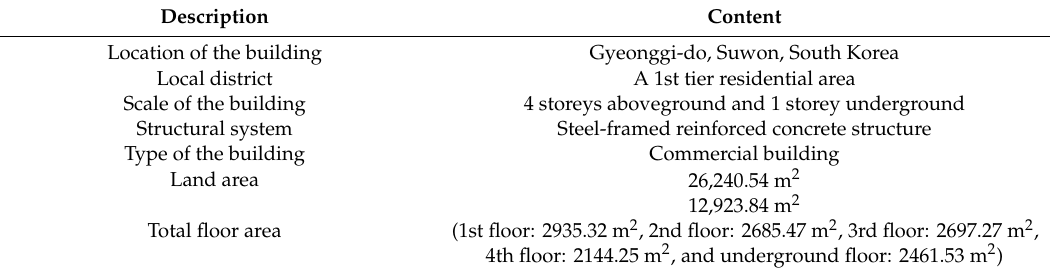
Table 1. The profile of the